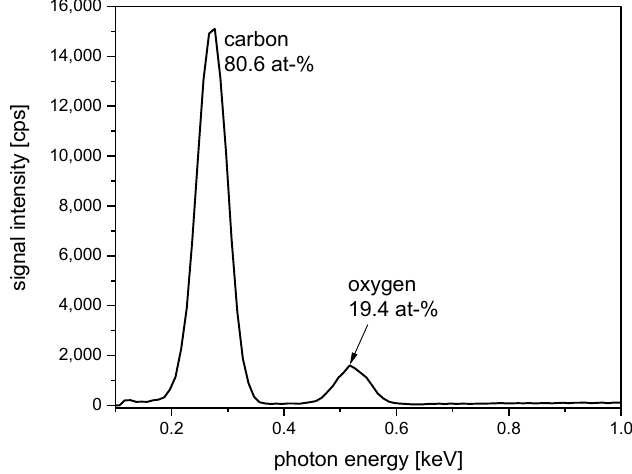
Figure 19. EDS spectrum of non-woven felt made from Kynol fibers.